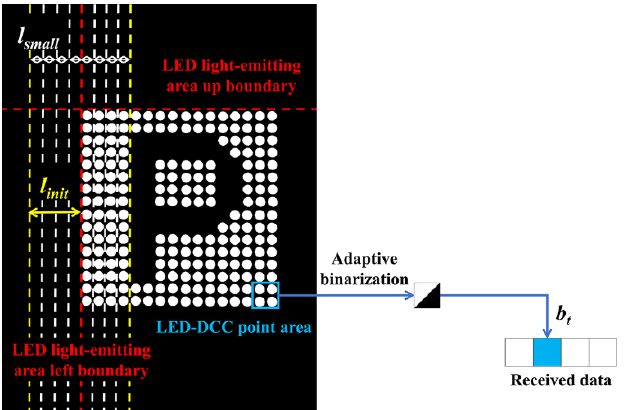
Figure 3. The demodulation procedure of lightweight, back-forth, fast image processing algo- rithm.